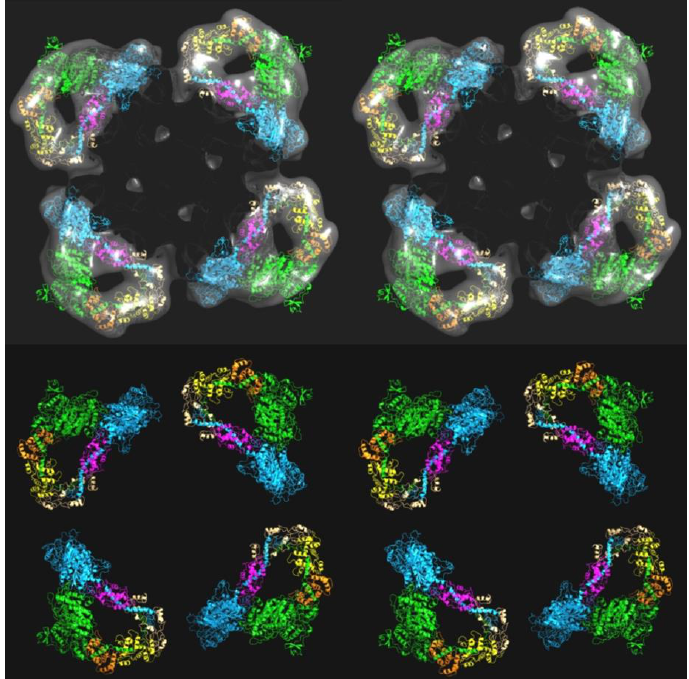
Figure 9. The models in Figure 8 shown looking down the filament axis, with the same colour coding. ( Top ) Density plus fitted model; ( Bottom ) Fitted model only. The head pairs form a good fit with a closed structure, as in the interacting head motif. closed structure, as in the interacting head